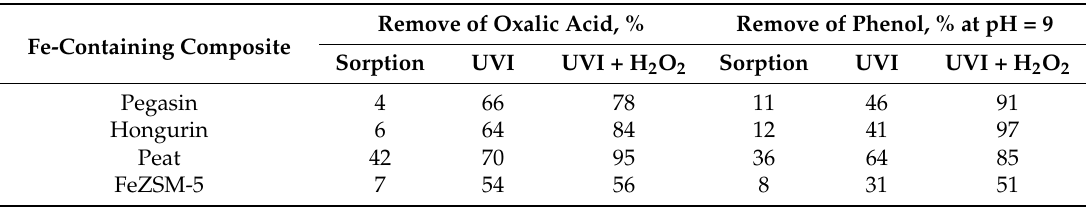
Table 1. The degree of degradation of organic pollutants from model solutions under normal conditions and under Ultraviolet irradiation (UVI) and (UVI + H 2 O 2 ) with natural iron-containing composites. The contact time is 30 min. Observational error 2–3% ( P = 0.95, n = 3). Remove of Oxalic Acid, % Remove of Phenol, % at pH = Fe-Containing Composite